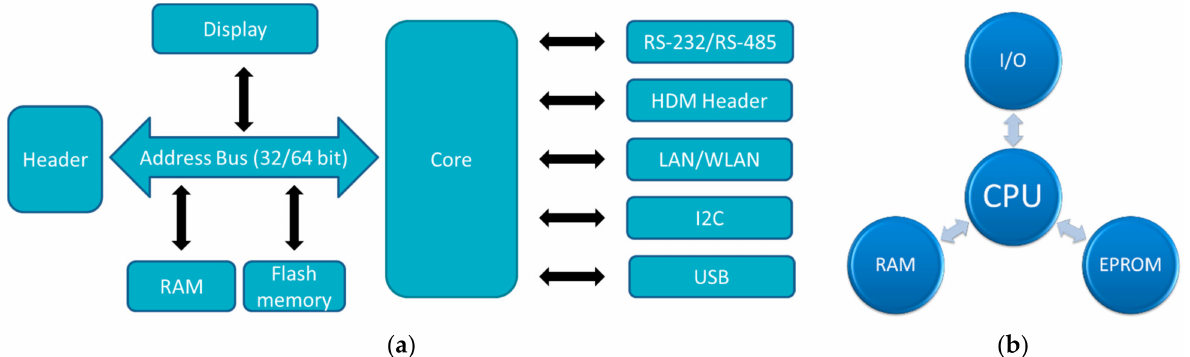
Figure 1. Architecture of ( a ) single board computers; ( b ) microcontrollers. Abbreviations: HDM— High Density Metric; LAN—Local Area Network; WLAN—Wireless LAN; I2C—Inter-Integrated Circuit; RS—Recommended Standard; I/O—Input/Output; CPU—Central Processing Unit; RAM— Random Access Memory; EPROM—Electrically Erasable Programmable Read-Only